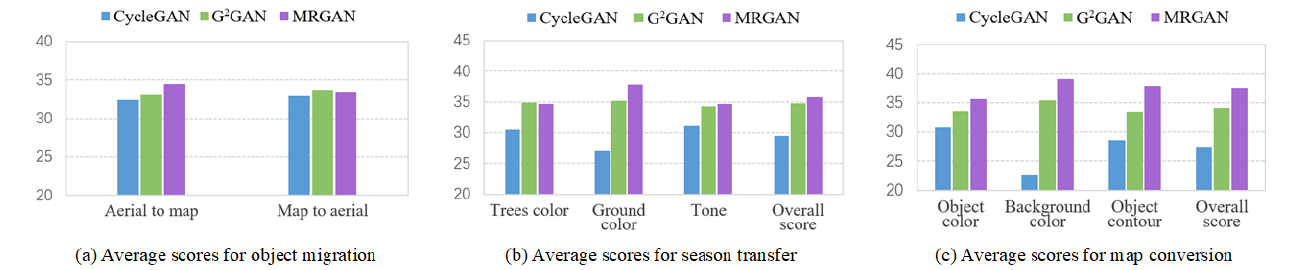
Figure 10. User study results confirm that our approach produces the best image translation results on three tasks. ( a ) The evaluation scores for different aspects in object migration between horses and zebras. ( b ) The evaluation scores for different aspects in season transfer between summer and winter images. ( c ) The evaluation scores for the boundary clarity in map